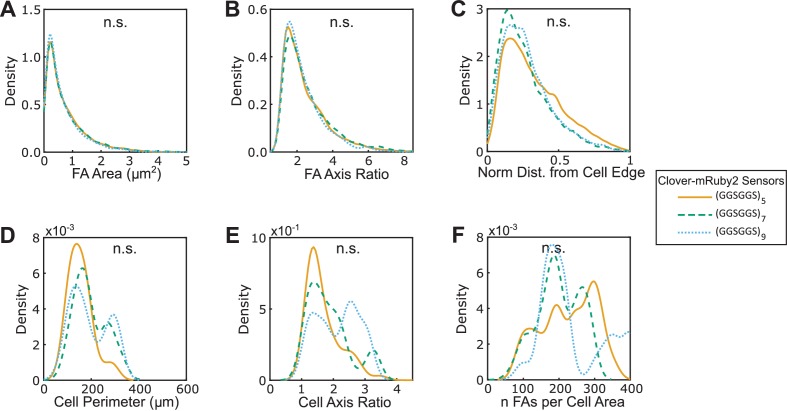
Three versions of VinTS respond similarly to softer substrates.(A-F) Vin-/- MEFs expressing various version of VinTS plated on 10 kPa gels show indistinguishable FA area (A), FA axis ratio (B), subcellular distributions of FAs quantified as normalized distance from cell edge (C), cell perimeter (D), cell axis ratio (E), number of FAs normalized by cell area (F). Different versions of the tension sensor were constructed with minimal Clover-mRuby2 modules flanking three distinct extensible domains, namely (GGSGGS)5 (n = 25 cells), (GGSGGS)7 (n = 25 cells), (GGSGGS)9 (n = 14 cells), pooled from three independent experiments; n.s. not significant (p≥0.05), ANOVA. See Supplementary file 4 for exact p-values.